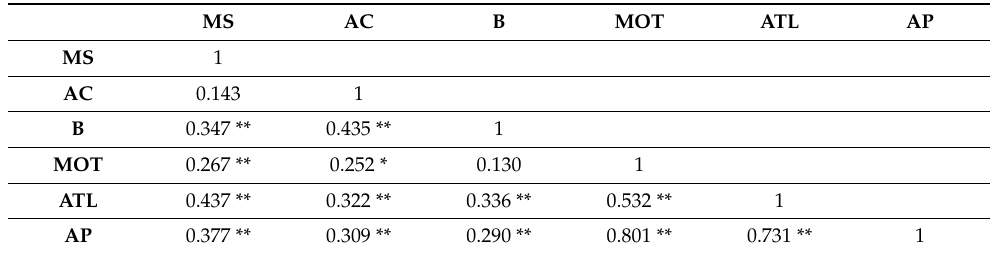
Table 5. Pearson’s correlation between learning and